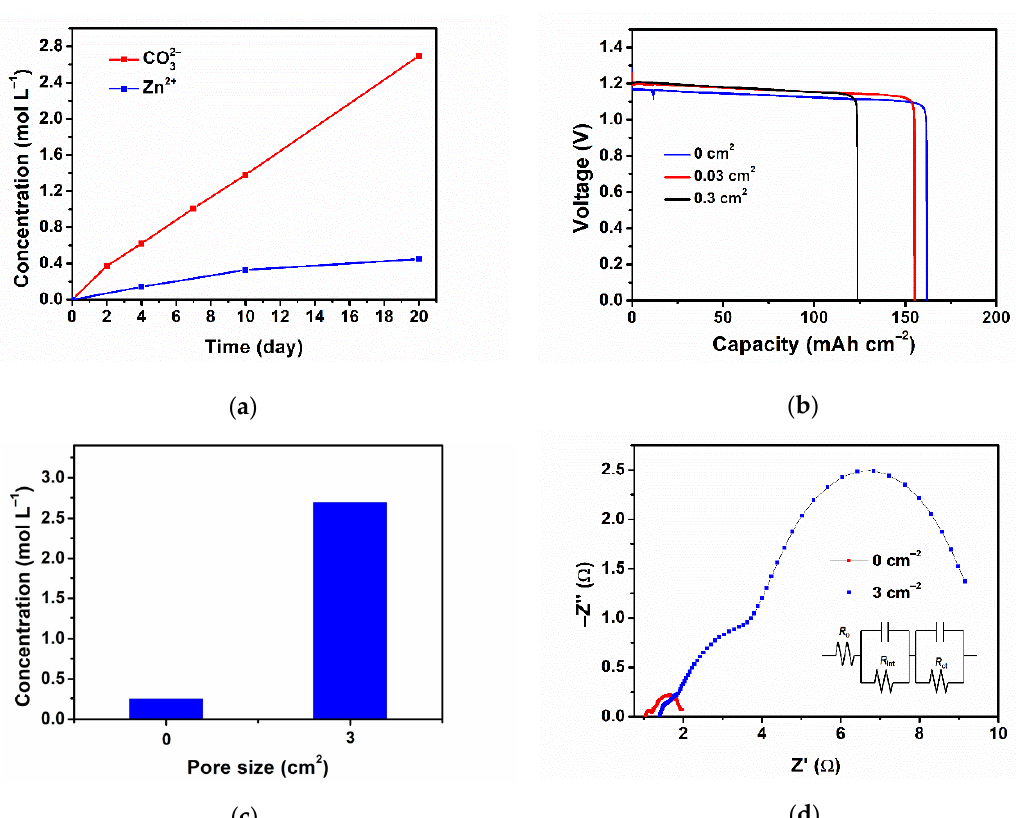
Figure 8. ( a ) The concentration variation of CO 32– and Zn 2+ in the battery electrolyte as the storage time increased. ( b ) The discharge curves of batteries with different air hole size after being stored under the same conditions for 20 days. ( c ) CO 32– concentration comparison of the electrolyte stored in the batteries with the air hole sizes of 0 cm 2 and 3 cm 2 for 20 days. ( d ) Nyquist plots of the batteries with different hole size after being stored for 20 days.